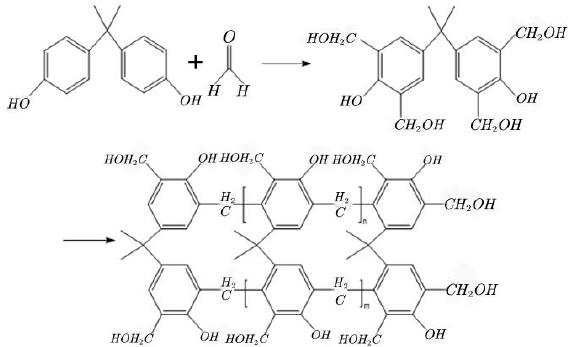
Figure 7. Synthetic route followed to prepare the crosslinker.